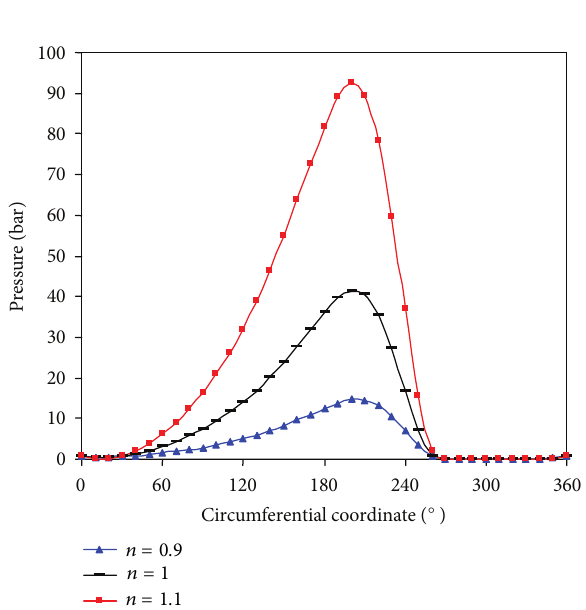
Figure 2: Pressure distributions versus the circumferential coordi- nate at the central plan of the journal bearing for different values of 𝑛